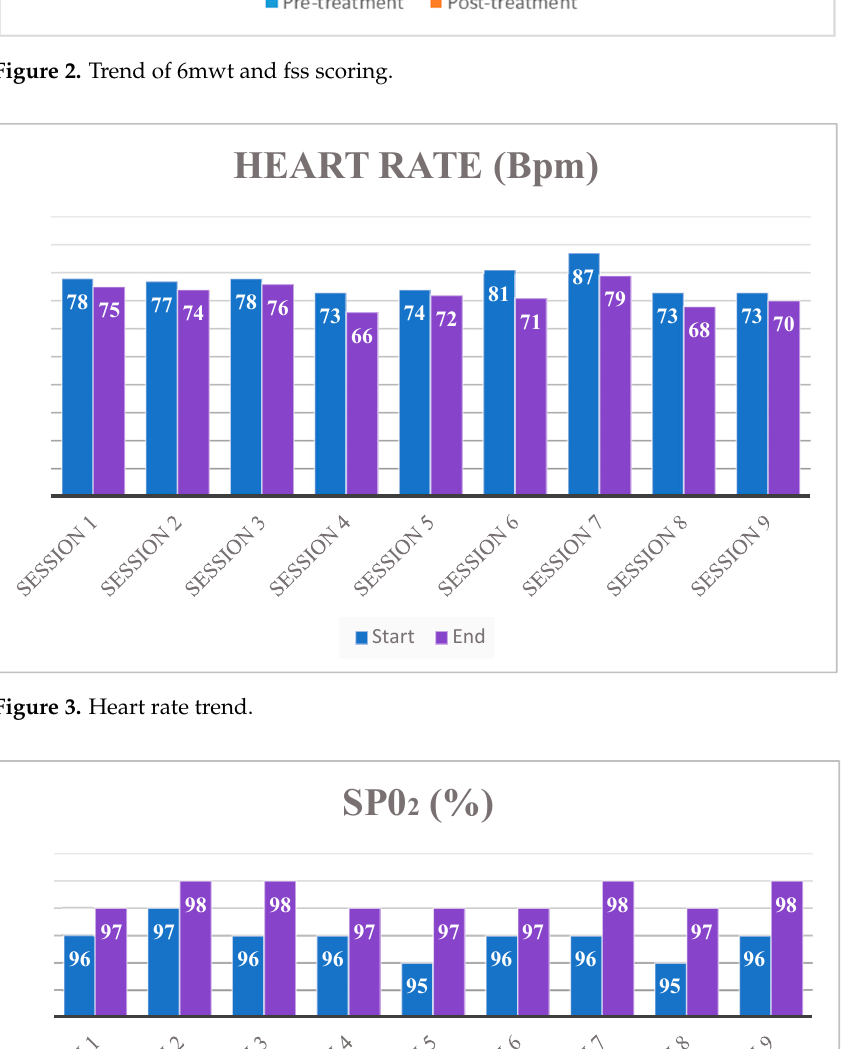
Figure 4. Trend of peripheral saturation (Sp0 2 ).